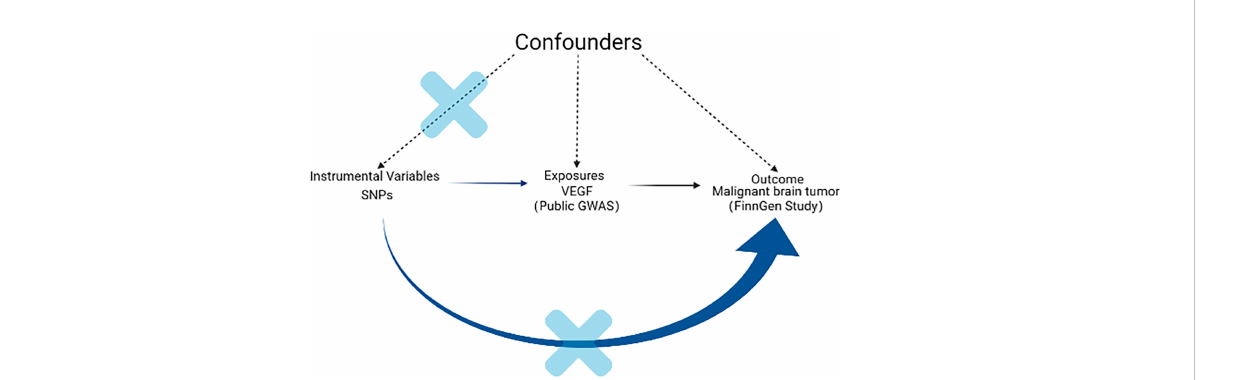
FIGURE 1 Schematic diagram of the MR design. The instrumental SNP was based on three key assumptions as follows: (1) the SNPs signi fi cantly related to exposure (VEGF) were selected as the instrumental variable ( P < 5 × 10 -8 ). (2) The SNPs have no association with confounders. Since genes are randomly assigned to the next generation of individuals following gametes during meiosis, there is little correlation between SNPs and confounding factors. (3) The SNPs should only be linked with outcome via exposure. Through sensitivity analysis such as MR-PRESSO, we excluded horizontal pleiotropy and restrictive assumptions to ensure that SNP affect the outcome (malignant brain tumor) only through exposure (VEGF). VEGF: vascular endothelial growth factor; SNP: single-nucleotide polymorphism; MR: Mendelian randomization; MR-PRESSO: pleiotropy residual sum and